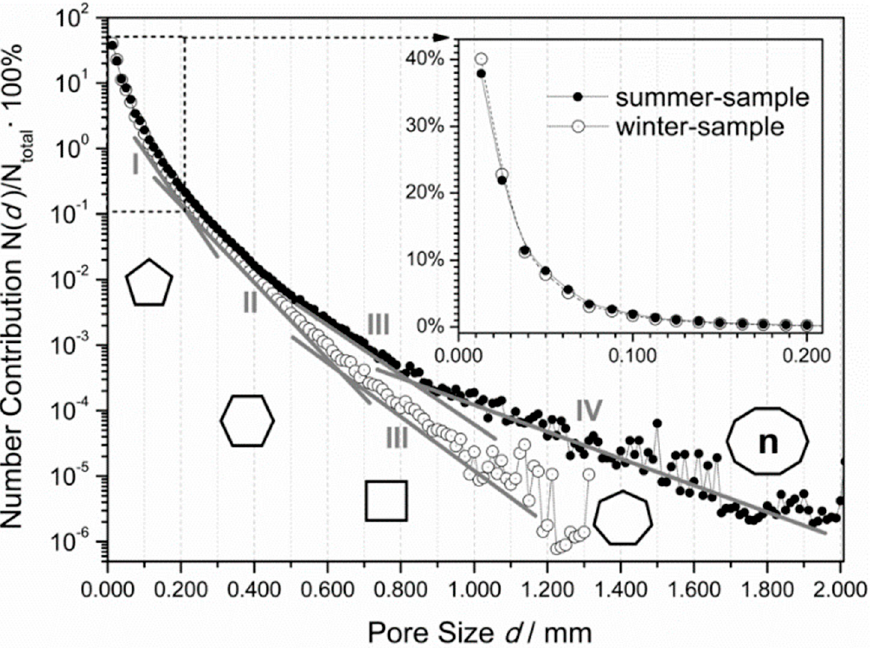
Figure 3. The number distribution of the pore size for both the W ‐ and S ‐ foam. The number contribution N ( d )/ N total of the pores of a given size to the total pore number in volume of interest (VOI) (BMP not resized, image pixel size 6.25 µm), shown as a function of the pore diameter, d, and plotted in the half ‐ logarithmic scale. The inset plotted in the linear scale is to enlarge the highlighted 0–200 microns range. The solid lines, numbers I, II, III, and IV are guiding the eye along the apparent straight intervals of a gradually variable slope. The shapes of the cell faces in the growing pores (5 ‐ , 6 ‐ , 4 ‐ , and 7 ‐ sided, with the last n ‐ sided polygon, where 7 < n < 20) are assigned to the corresponding intervals (I–IV), also given their frequency of appearance in the expanding PU foams (see discussion).